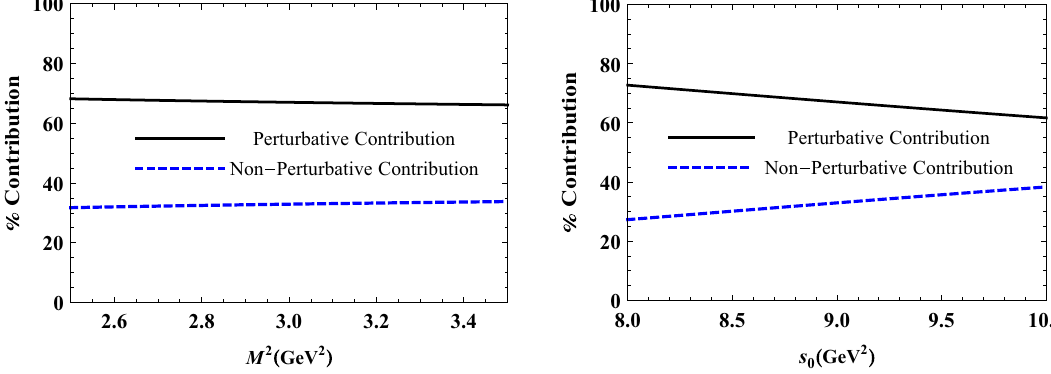
Fig. 3 The perturbative and nonperturbative contributions to (cid:6) QCD ( M 2 , s 0 ) of the scalar particle. Left: as functions of M 2 at central value s 0 = 9 GeV 2 , right: as functions of s 0 at M 2 = 3 GeV